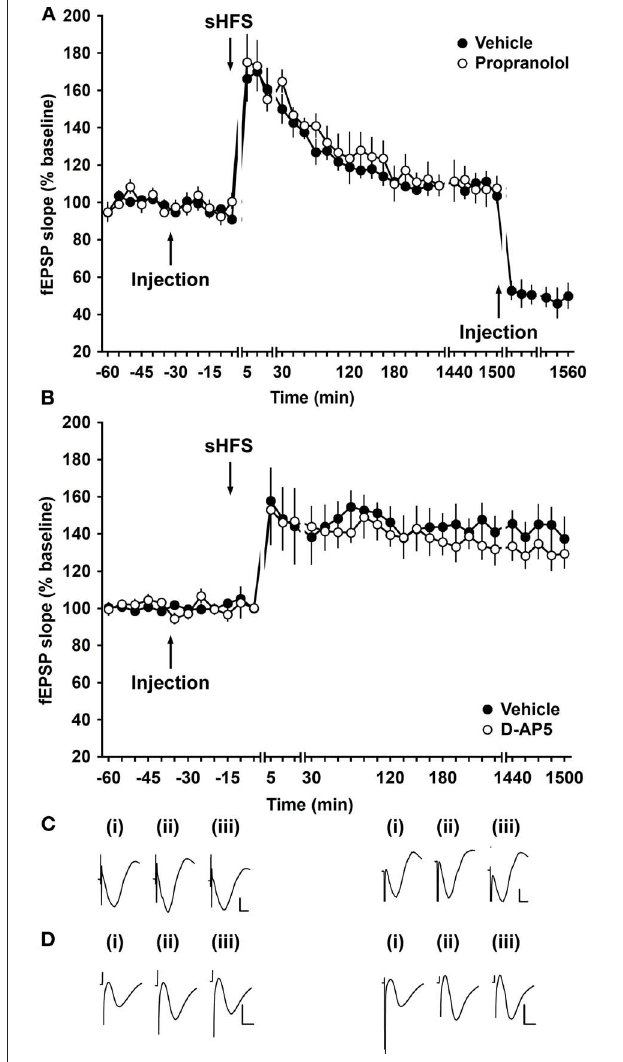
FIGURE 2 | Electrically induced STP of mossy fiber synapses is not altered by application of a β -adrenergic receptor antagonist. (A) Application of sHFS (two trains of 100 pulses at 100Hz) results in STP. Treatment with the β -adrenergic receptor antagonist, propranolol (2 μ g), did not change the responses elicited. After responses had returned to baseline levels, DCG-IV was applied to confirm that responses were evoked by stimulation of mossy fibers. Line breaks indicate changes in time scale. (B) Application of the NMDA receptor antagonist, D-AP5 (3.9 μ g) 30min prior to stimulation does not alter evoked responses of LTP at mf-CA3 synapses compared to control animals. Line breaks indicate changes in time scale. (C) Analog traces were recorded (i) 5min pre-sHFS, (ii) 5min post-sHFS, and (iii) 24h after sHFS in the presence of vehicle ( left panel ) or propranolol ( right panel ). Vertical scale bar: 2mV, horizontal scale bar: 6ms. (D) Analogs of fEPSP responses (i) 5min pre-injection, (ii) 5min post-injection, and (iii) 24h post-injection of animals that received D-AP5. Vertical scale bar: 2mV, horizontal scale bar 6ms.